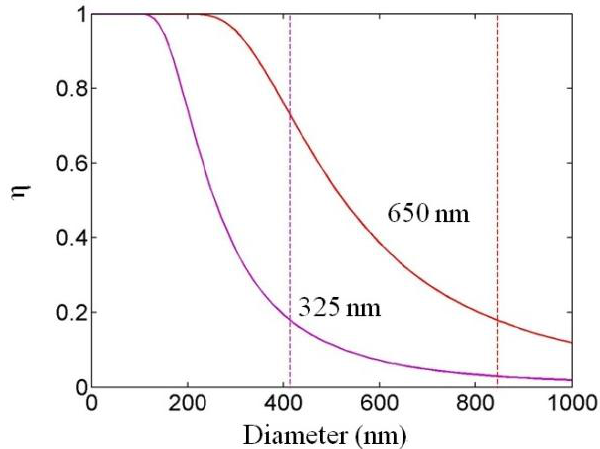
Figure 3. Fractional power of the fundamental mode outside the core of silica microfibers at 325 and 650 nm wavelength. Dashed lines: single-mode cutoff diameters